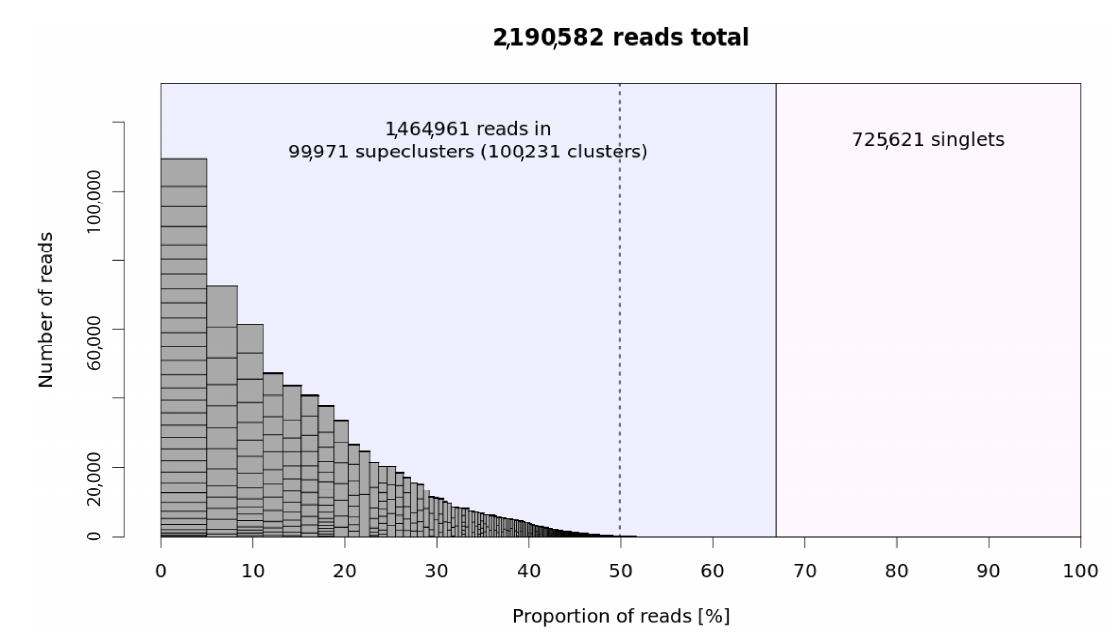
Figure 1. Graphical summary of hybrid clustering results. The bars represent superclusters, with their heights and widths corresponding to the number of reads in the superclusters (y-axis) and their proportions in all analyzed reads (x-axis), respectively. The rectangles within the supercluster bars represent the individual clusters. The blue and pink background panels show the proportions of reads that have been clustered and those that have remained single, respectively. The top clusters are to the left of the dotted line.